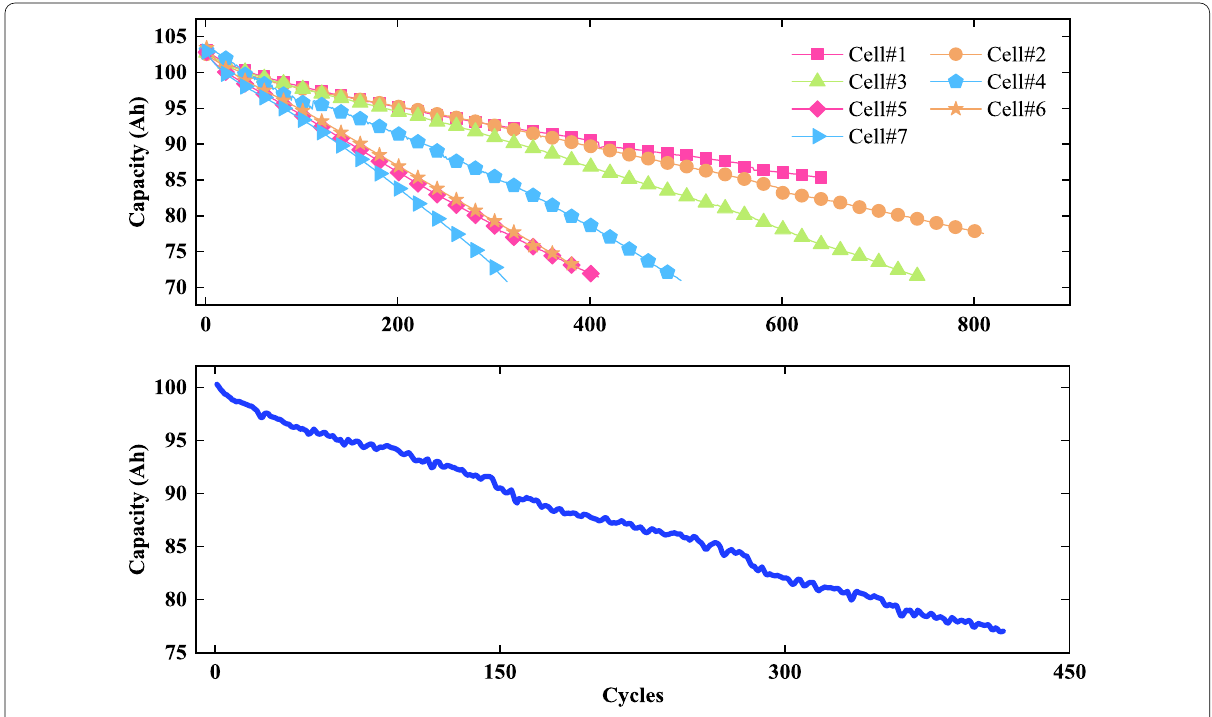
Figure 1 Capacity degradation of the SBCs and battery